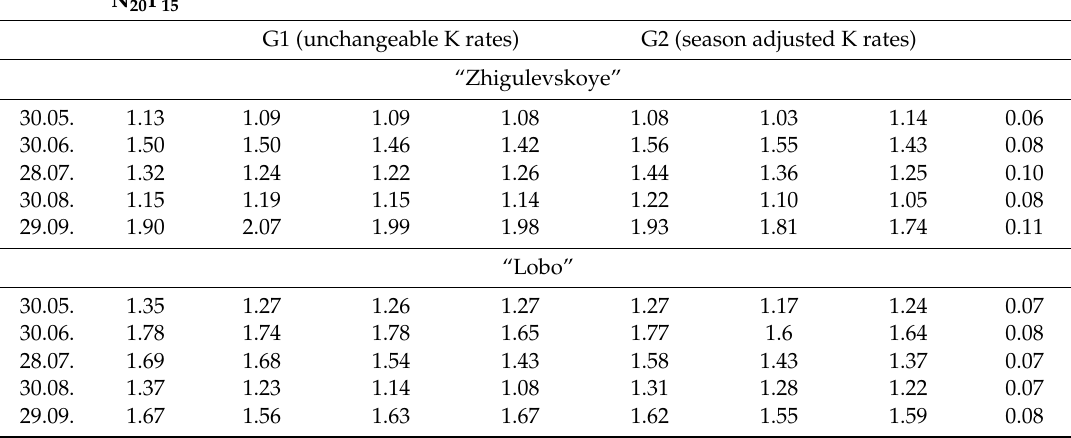
Table 13. Seasonal changes of the calcium leaf status under the influence of di ff erent potassium fertilization rates and fertigation approaches in 2016, %